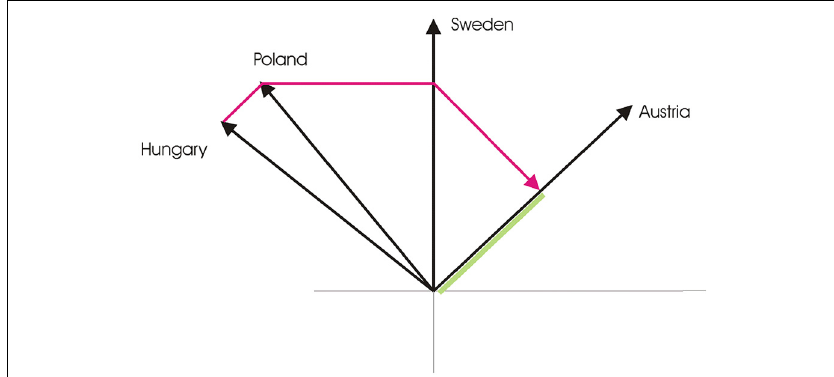
FIGURE 1 | An illustration of the series of projections, relevant to the similarity of Sweden to Austria, in the context of Poland and Hungary (assuming all countries are represented as rays). The red line shows the series of projections: P Hungary P Poland P Sweden P Austria | ψ the squared length of this projection (indicated in green). The last two projections correspond to the similarity comparison and the first two to the context. Note, also, that projections across context elements need be counterbalanced, but, for simplicity, in the example we illustrate only one order (from Hungary to Poland). Finally, with this context, the similarity judgment is going to be higher, compared to having context elements not grouped